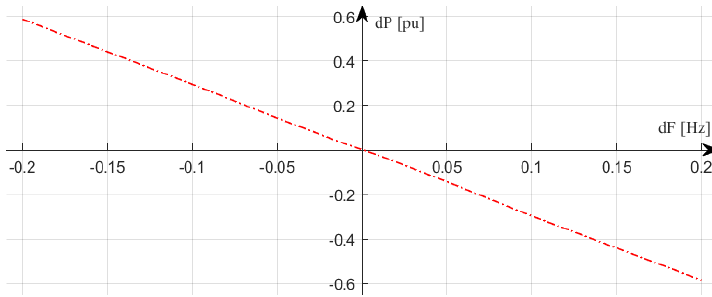
Figure 6. Droop control curve for frequency regulation as implemented in BESS under test.